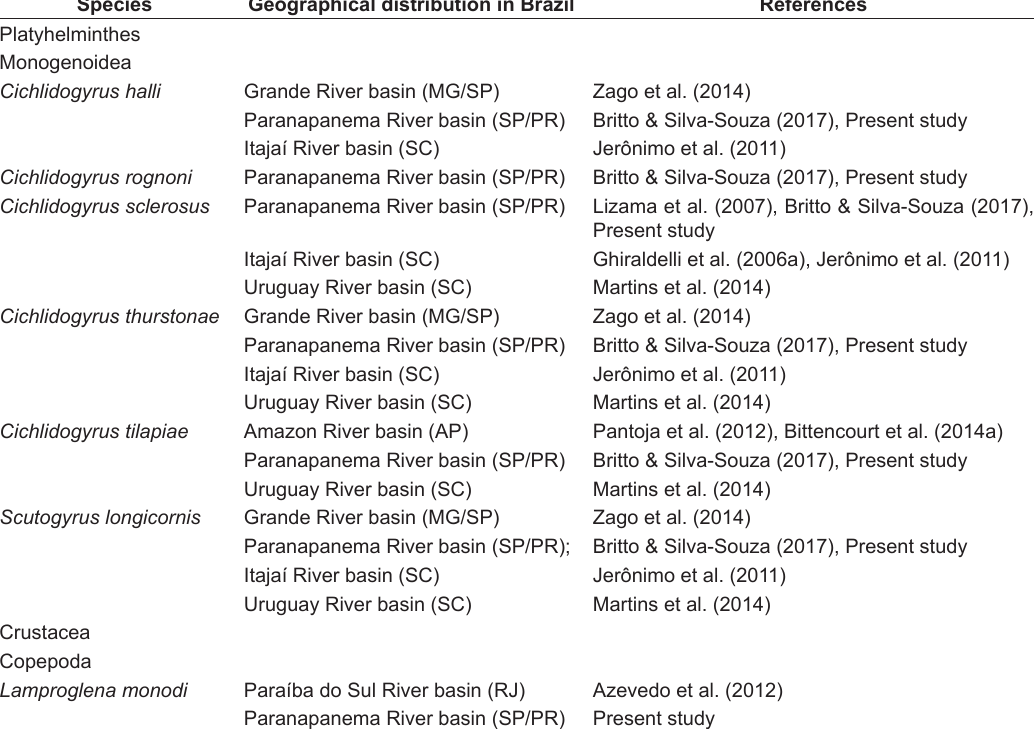
Species Geographical distribution in